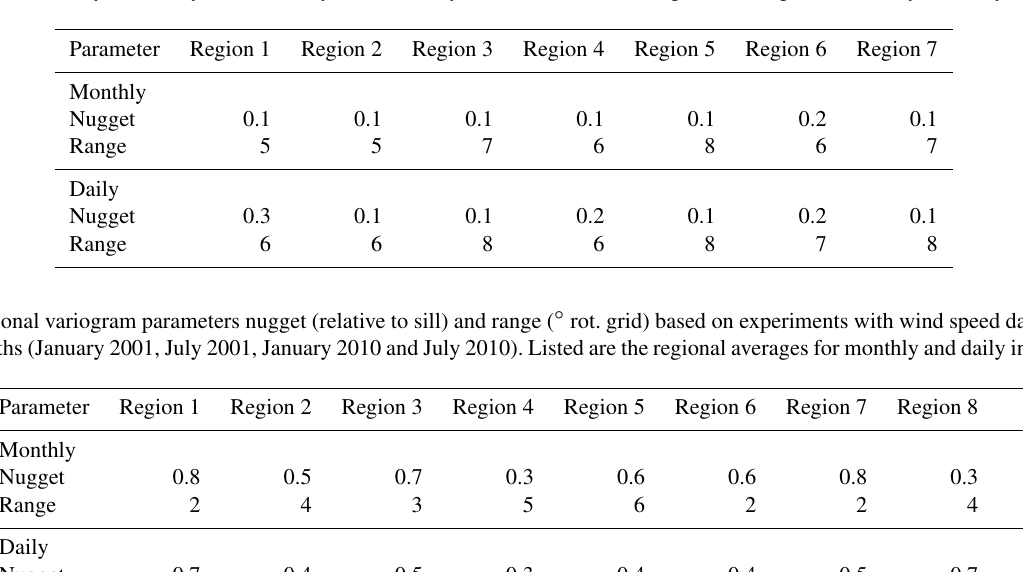
Table 3. Regional variogram parameters nugget (relative to sill) and range ( ◦ rot. grid) based on experiments with temperature data T avg of 4 example months (January 2001, July 2001, January 2010 and July 2010). Listed are the regional averages for monthly and daily interpolation.